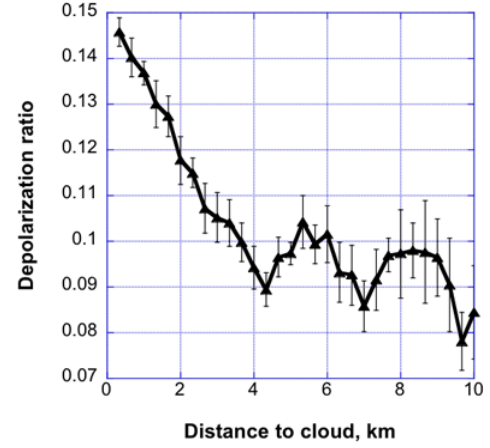
Fig. A5. Estimated particulate depolarization ratio as a function of distance to clouds for low dust. This panel corresponds to Fig.